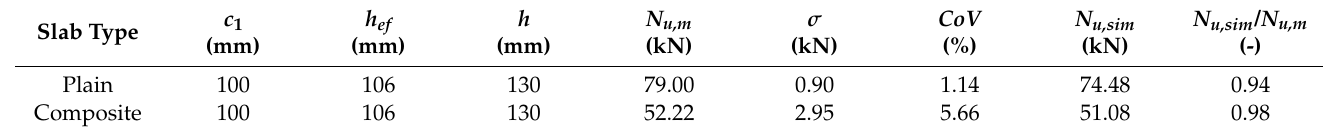
Table 1. Comparison between experimental and numerical results—4 tests were performed for each